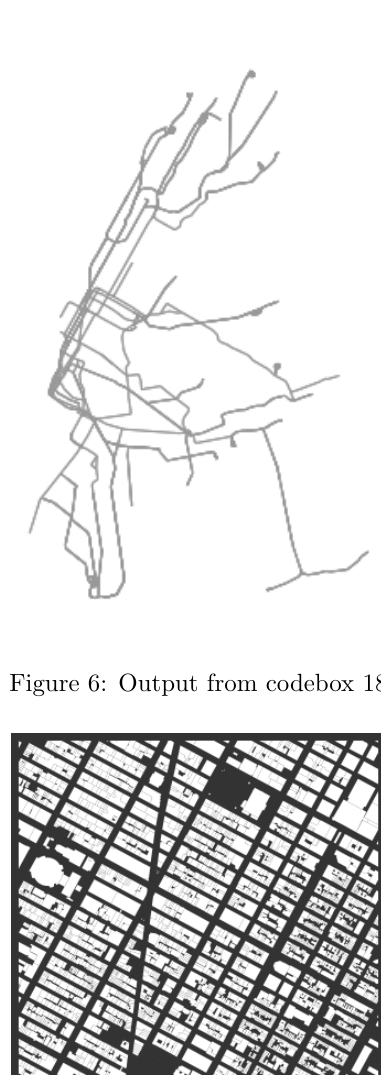
REGION : Volume 6, Number 3,